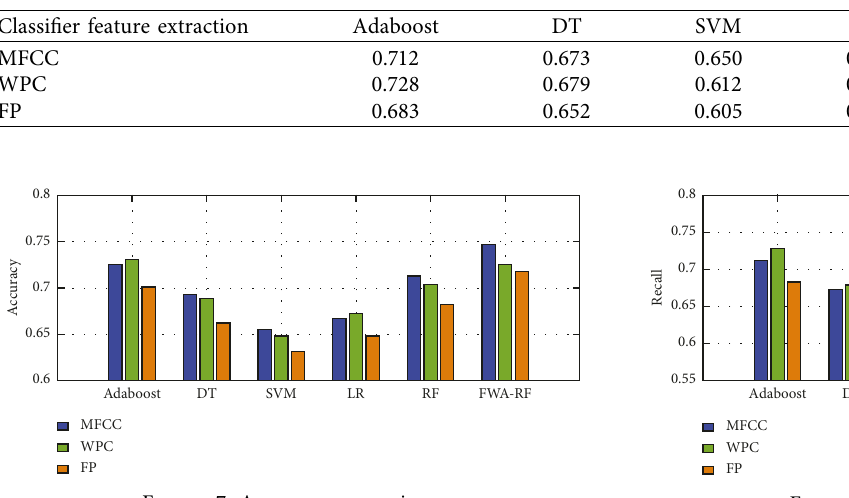
Figure 8: Comparison of